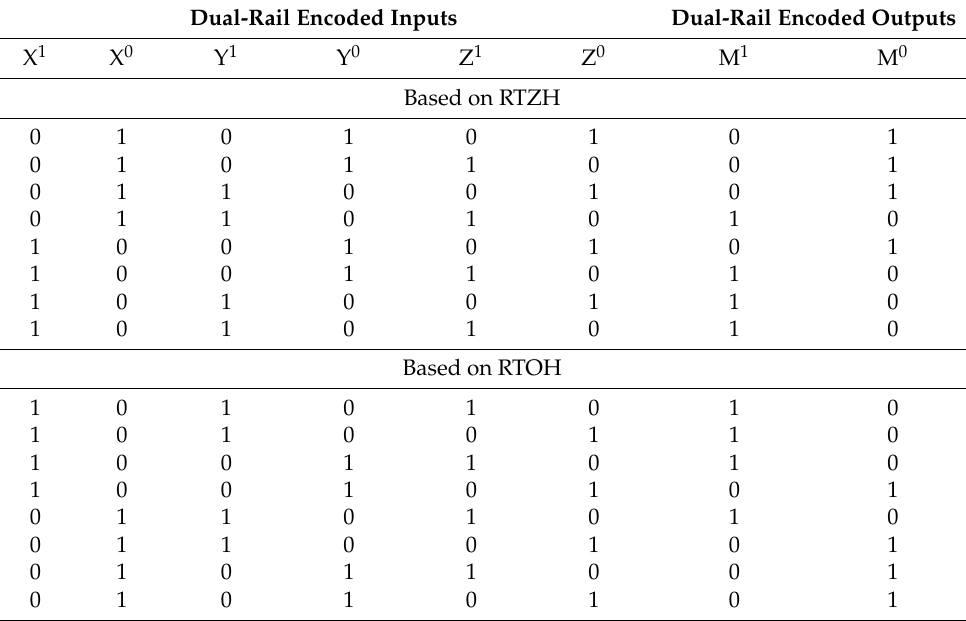
Table 2. Truth table of the dual-rail encoded majority voter (showing only data and no